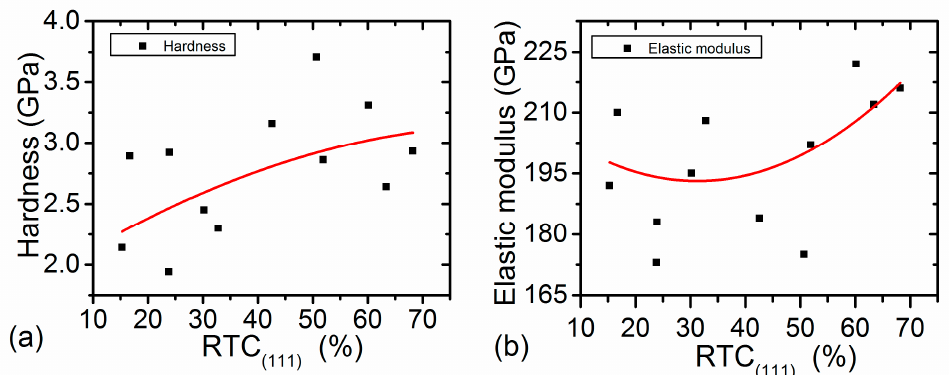
Figure 10. ( a ) Variation of hardness with RTC111; ( b ) variation of elastic modulus with RTC111.